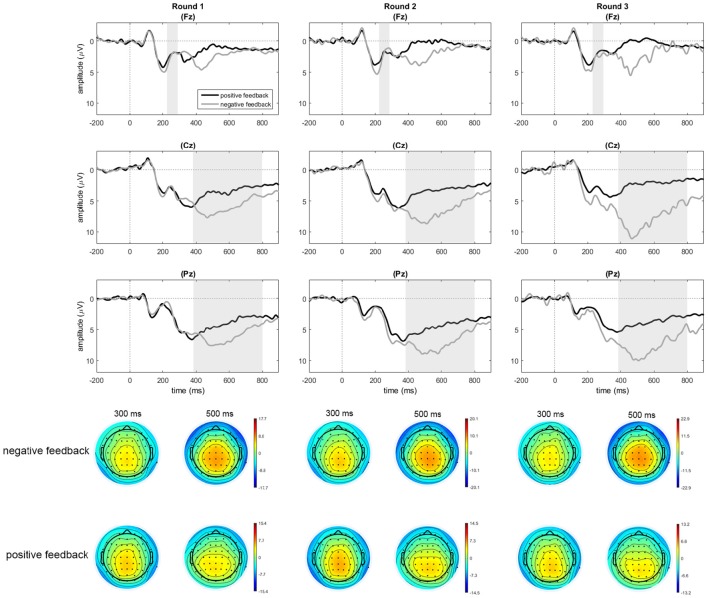
Feedback-locked data for positive and negative feedback in rounds 1, 2, and 3 at electrodes Fz, Cz, and Pz. Only for the purpose of depicting the data, an additional baseline correction was performed over the pre-feedback window starting from −200 ms. Shaded areas indicate the average time windows of the FRN trough-to-peak measure (Fz), running from the trough latency to the peak latency, and the time window of the mean amplitude for the P300 measure (Cz, Pz).